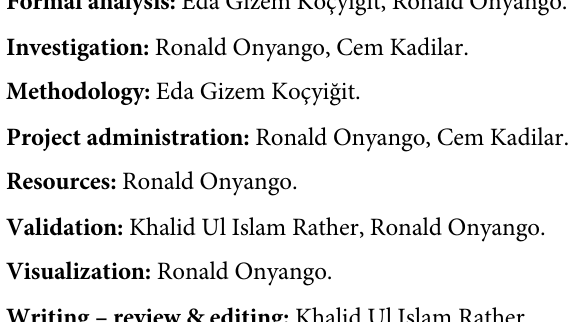
under symmetric and skewed UK 1